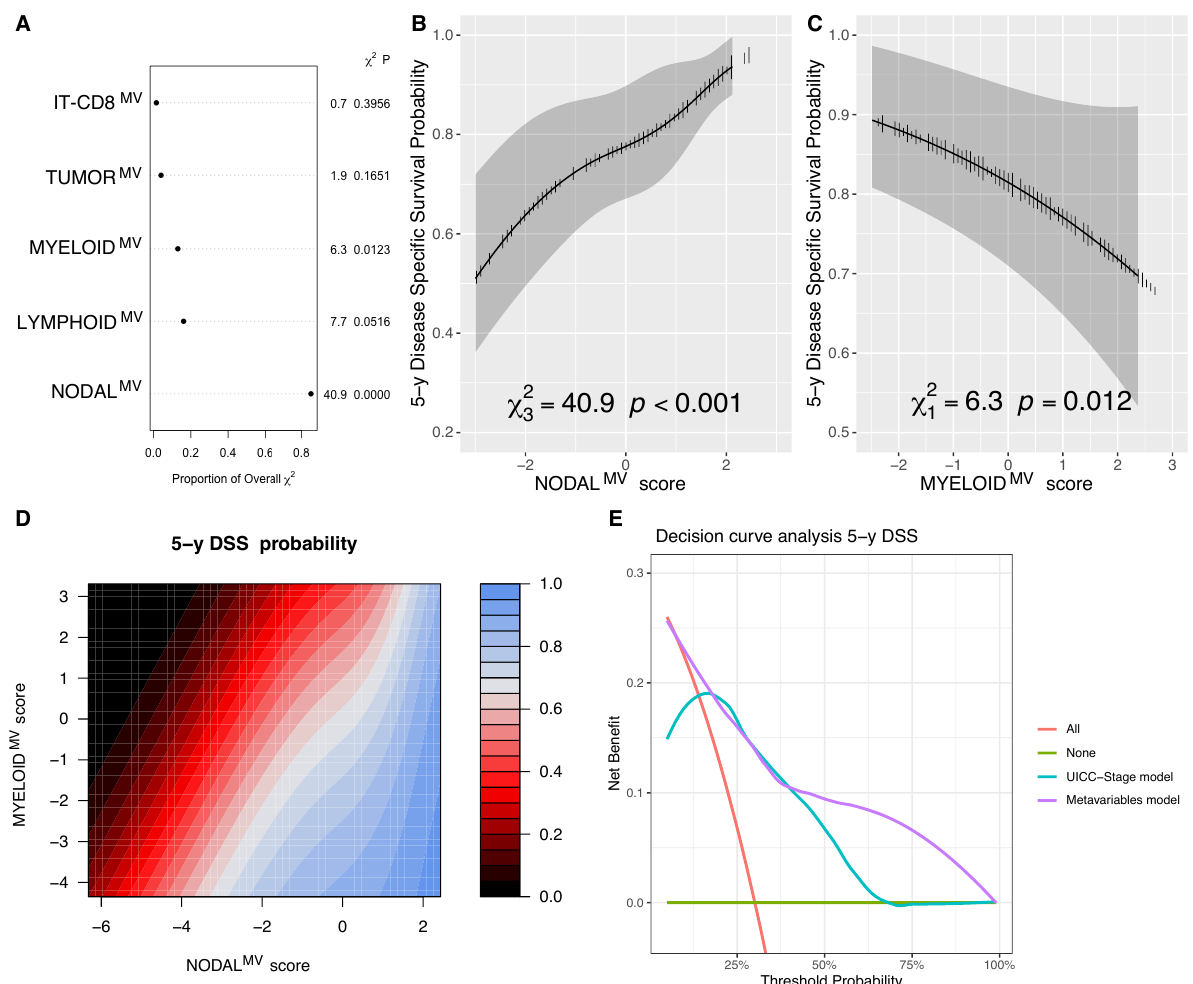
Figure 4. Chunk test results on the DSS multivariable model reporting the proportion of the overall χ 2 of the model explained by each variable, the partial χ 2 and p value of the Wald test, testing the association between each variable and the outcome ( A ); adjusted marginal effect plots for the 5-year DSS with CI 95% (gray bands) of the NODAL MV ( B ) and MYELOID MV ( C ) scores; contour plot showing isoprognostic DSS bands according to the combined effect of the NODAL MV and MYELOID MV scores for the 5-year DSS estimate, the color scale represents the 5 y DSS probability ( D ); and decision curve analysis (DCA) showing the advantages of the model including MV compared to the one fitted with UICC overall stage alone in predicting the 5-year DSS ( E